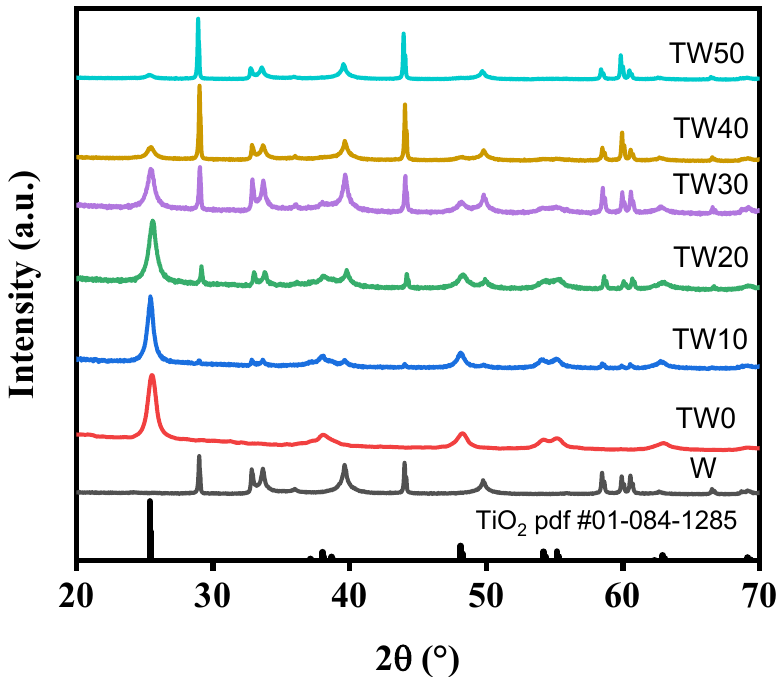
Figure 1. XRD for W, TW0, TW10, TW20, TW30, TW40 and TW50 nanofibers of TiO 2 :WS 2 (0:1, 1:0, 0.9:0.1, 0.8:0.2, 0.7:0.3, 0.6:0.4 and 0.5:0.5, respectively).